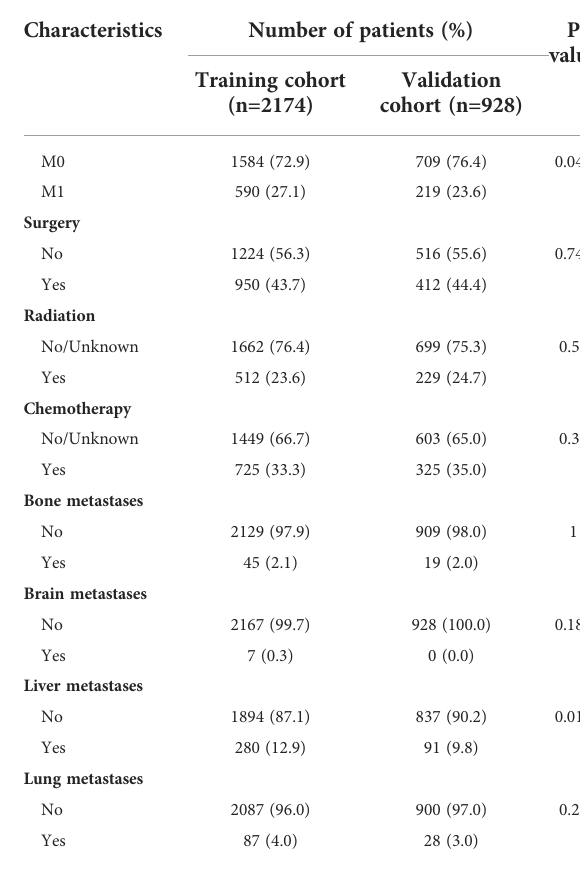
TABLE 2 The baseline characteristics of the training and validation